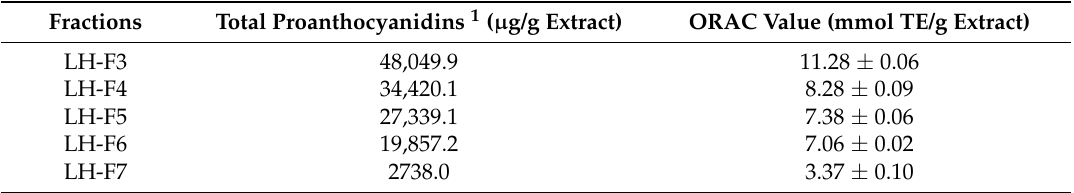
Table 2. Total proanthocyanidins (UPLC/TQ-ESI-MS analysis) and antioxidant activity of fractions from U. tomentosa